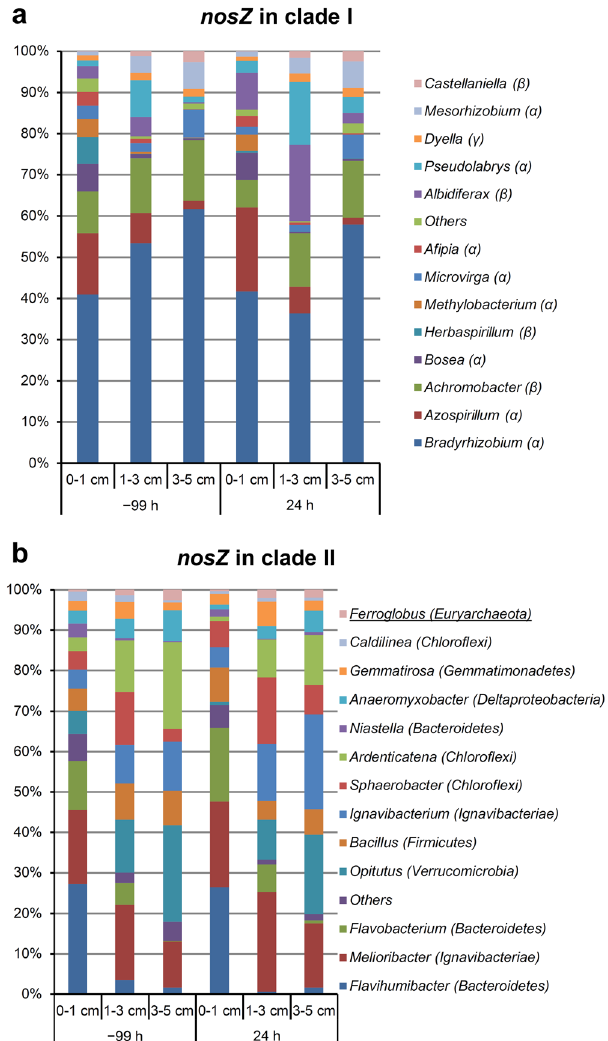
Figure 4. Average relative abundances of nosZ in clade I ( a ) and nosZ in clade II ( b ) sequences affiliated with taxonomic groups at the genus level. Each group is labeled with its genus name, with its phylum or subphylum name in parenthesis. Groups with < 1% sequence number in the 18 soil samples were merged into the “Others” group. α , β , and γ represent alpha- , beta- , and gamma-proteobacteria , respectively. The underlined taxonomic name in ( b ) indicates an Archaea